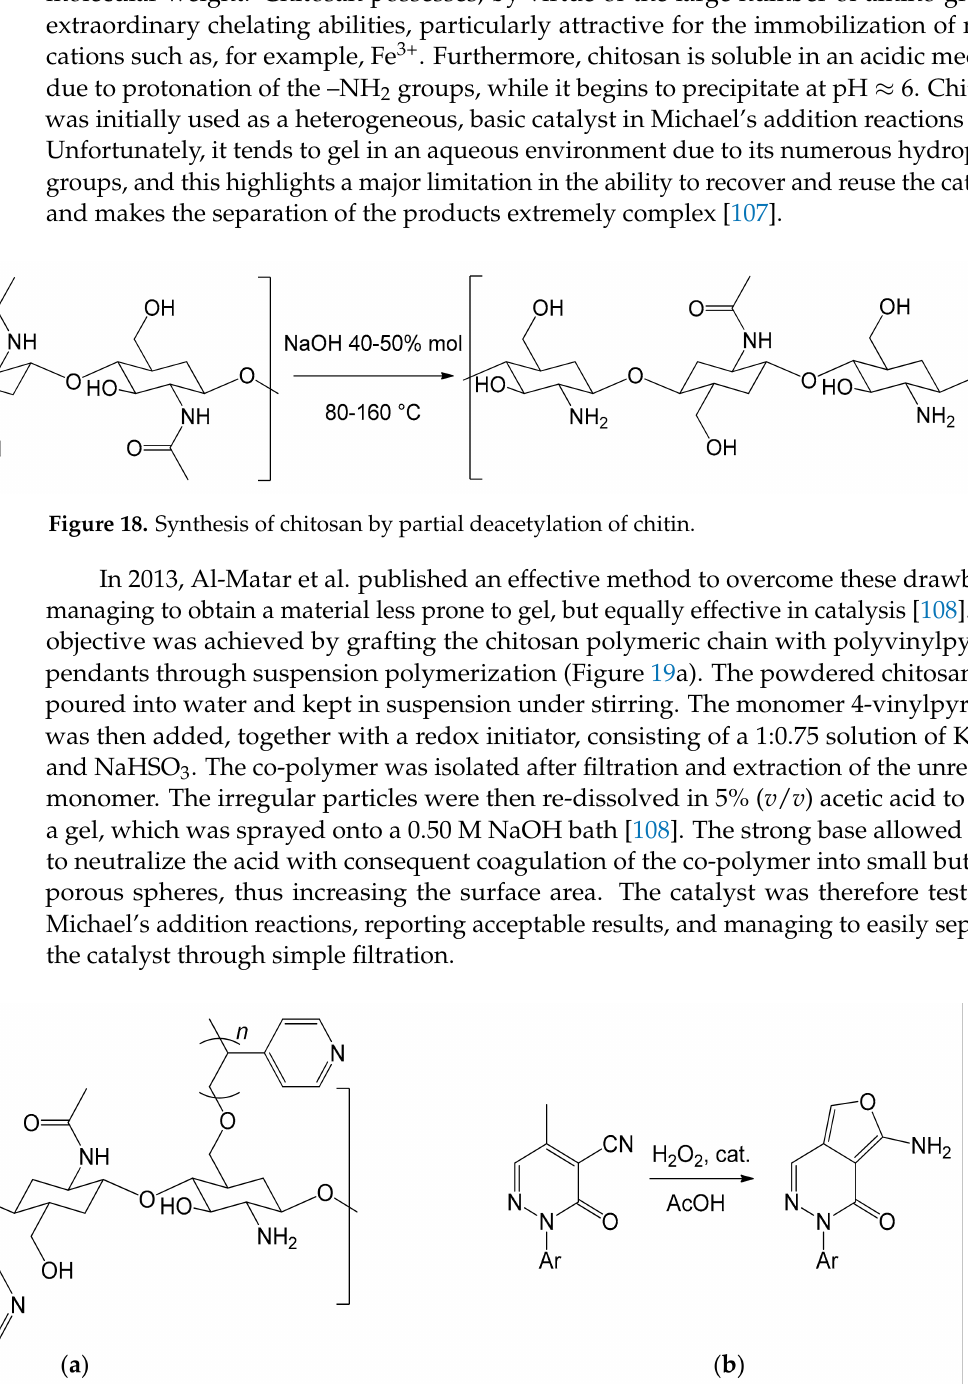
Figure 19. ( a ) Chitosan polymeric chain grafted with polyvinylpyridyl pendants; ( b ) Oxidation reaction of methylpyridazone using the grafted chitosan with immobilized Fe 3+ ions as catalyst (Ar = phenyl, 4-chlorophenyl)